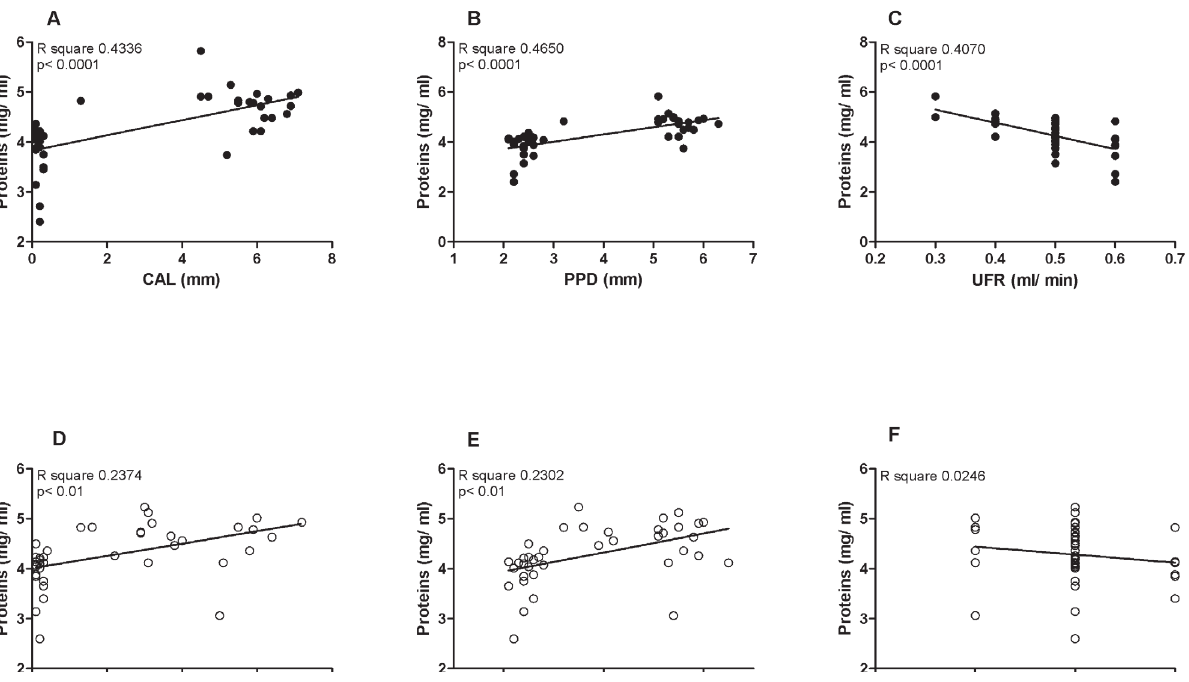
Figure 7- Pearson’s correlation analysis between total proteins and clinical attachment level (CAL) (A and D), probing pocket depth (PPD) (B and E) and unstimulated flow rate (UFR) (C and F) in aggressive periodontitis (AgP) (upper panel) and chronic periodontitis (CP) (lower panel)